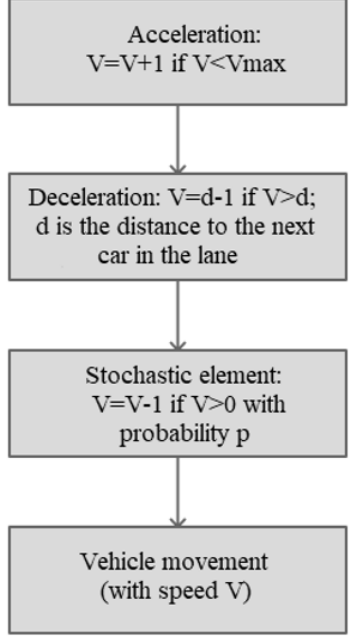
Fig. 2. Nagel-Schreckenberg model rules for movement along a road